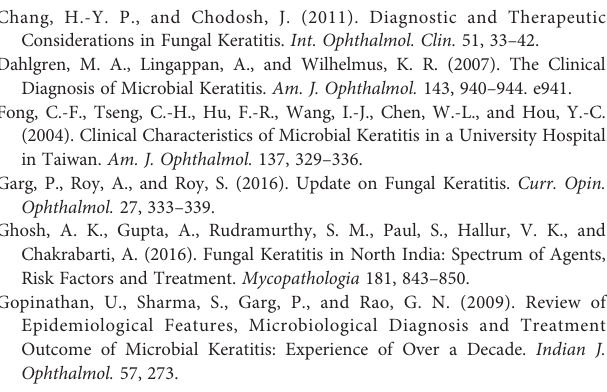
Supplementary Figure 14 | The forest plot of the prevalence of yeast and mold keratitis among patients undergone keratoplasty based on the reported